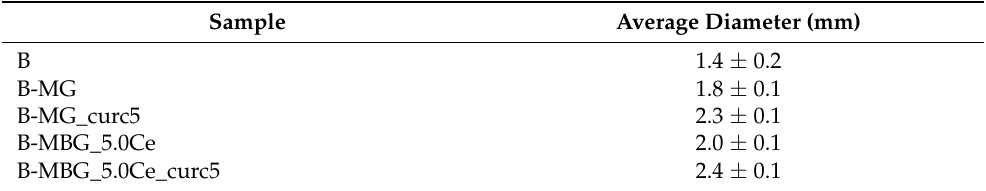
Figure 2. Beads images obtained with optic microscope. In order: ( a ) B; ( b ) B-MG; ( c ) B-MG_5.0Ce; ( d ) B-MG_curc5; and ( e ) B-MG_5.0Ce_curc5. The numbers identify different beads of the same sample. Table 2. Average dimensions of synthesized beads.